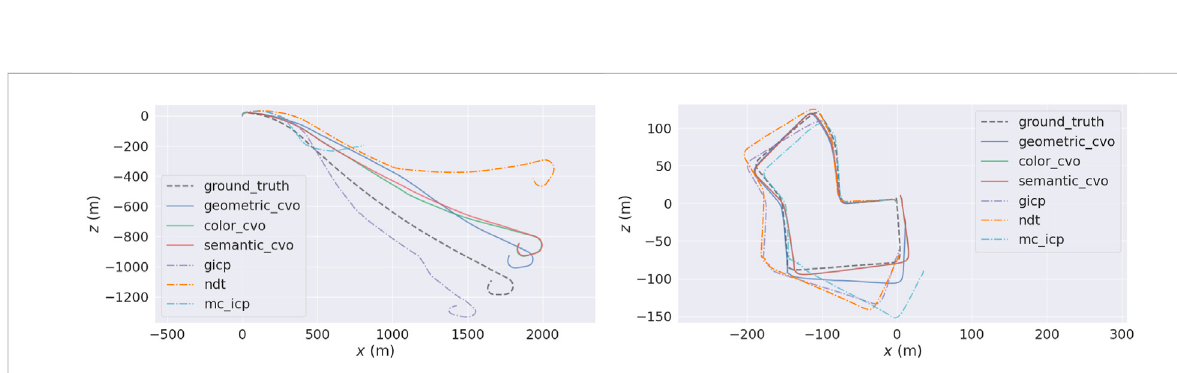
FIGURE 3 An illustration of the proposed registration methods on KITTI Stereo (Geiger et al., 2012) sequence 01 (left) and 07 (right) versus the baselines. The black dashed trajectory is the ground truth. The dot-dashed trajectories are the baselines. Plotted with EVO (Grupp,